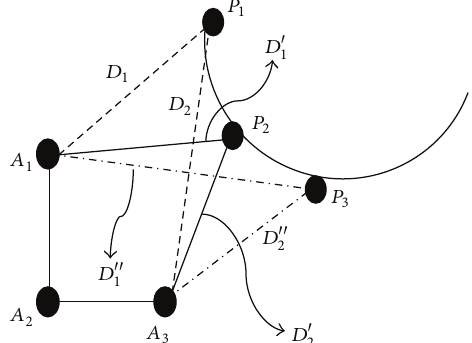
Figure 16: A figure to illustrate how the resultant delay times could be either positive or negative. A small portion of the lightning path shown in Figure 14 is redrawn here. Moving from 𝑃 1 to 𝑃 3 , first at 𝑃 1 , > 𝐷 𝑃 𝐷 = 𝐷 𝐷 2 1 , then at 2 , 2 1 , and finally at